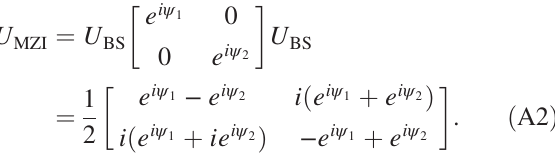
FIG. 6. The Mach-Zehnder interferometers (a) and (b) are described by precisely the same unitary matrix U interferometer in (c) is described instead by an equivalent matrix U 0 ¼ C U MZI , where C is a diagonal matrix with only MZI phase